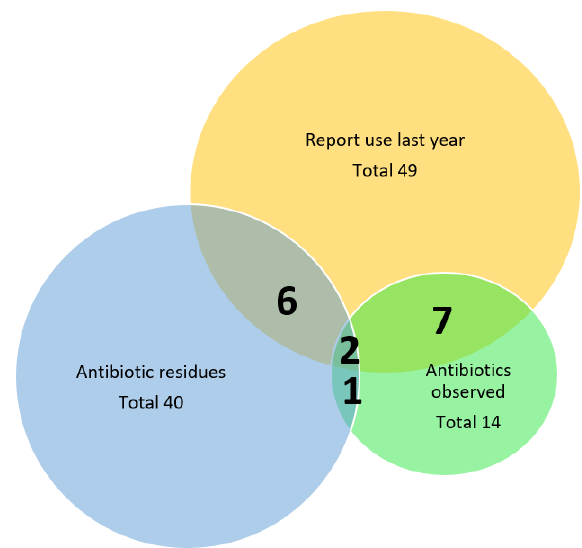
Figure 1. Venn diagram illustrating low correlation between farmer questionnaire responses, antibiotic residues found in milk samples, and antibiotics found on farms during farm inspections.